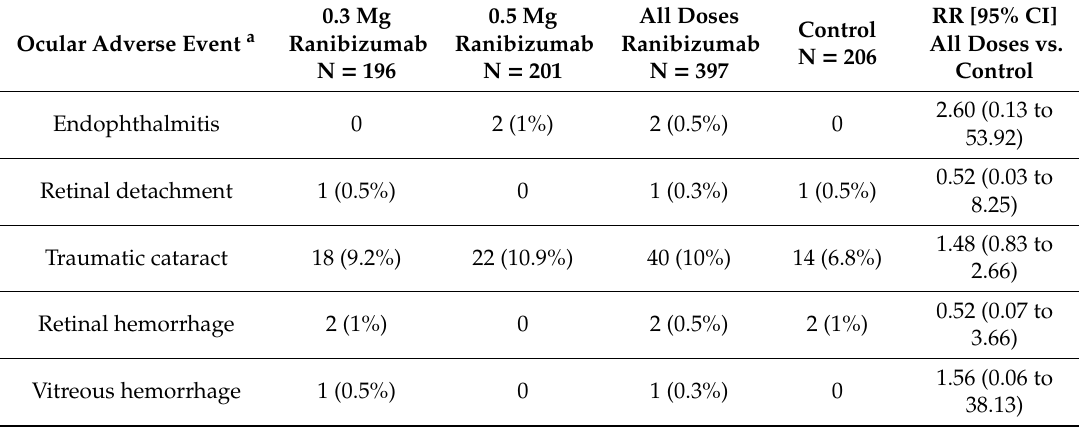
Table 5. An overview of ocular adverse events reported by age-related macular degeneration patients treated with ranibizumab. Adapted from Solomon et al.